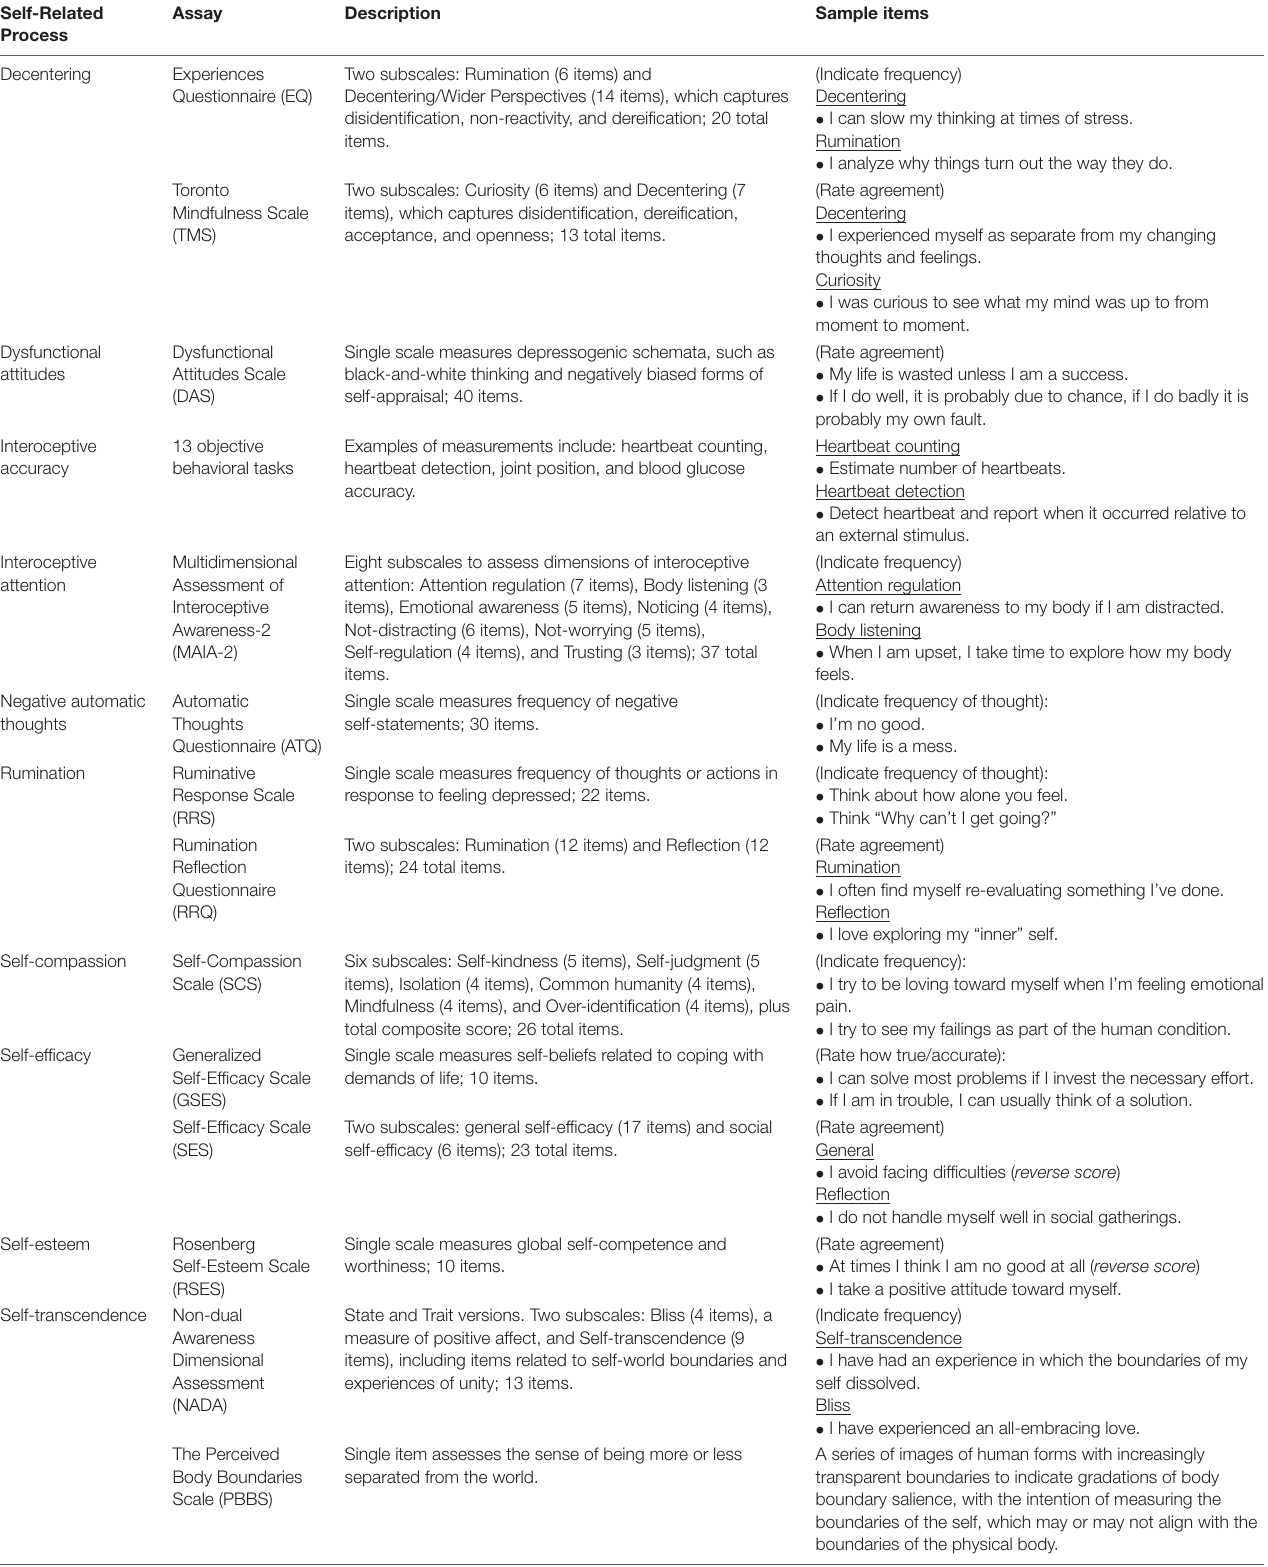
TABLE 1 | Common measurement tools for self-related processes. Self-Related Assay Description Sample Process